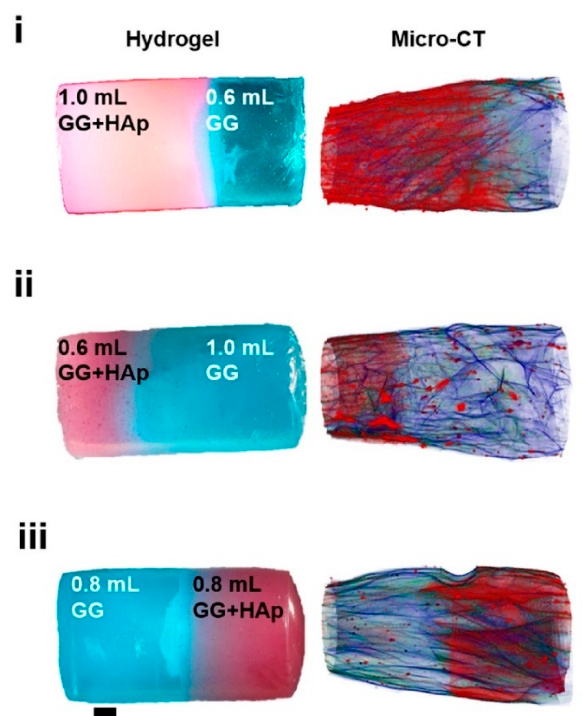
Figure 7. 3D images of hydrogels with different solution volume ratios and different HAp distribu- tion and polymeric architecture reconstructed by micro-CT